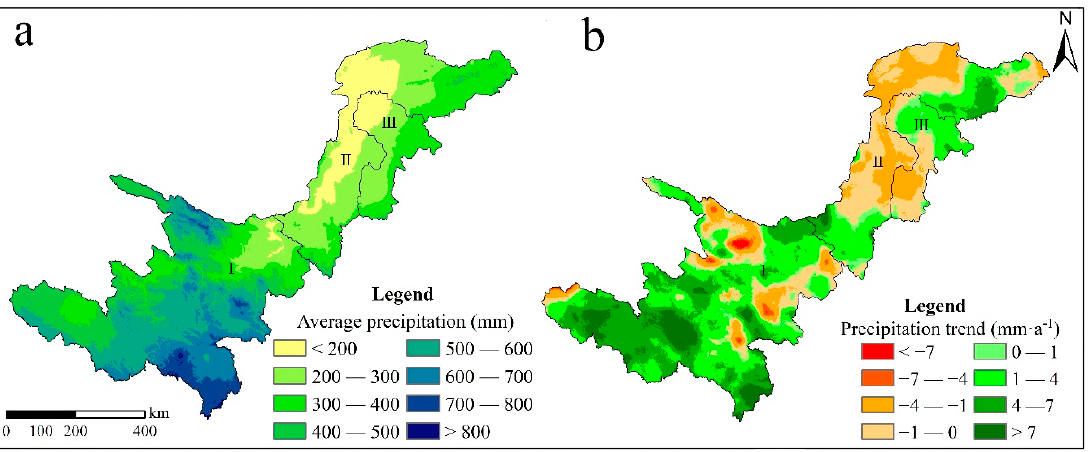
Figure 11. Spatial distributions of the average precipitation ( a ) and precipitation trends ( b ) recorded in the study area from 2000 to 2019.